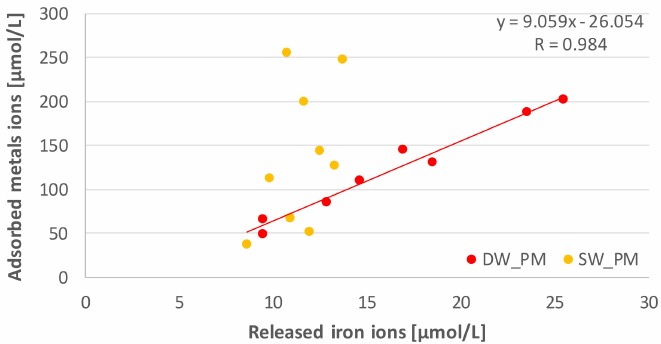
Figure 5. Relationship between the amount of iron released from alginate matrices cross-linked with Fe 3 + ions and the total amount of metal ions adsorbed from a 1 L solution.